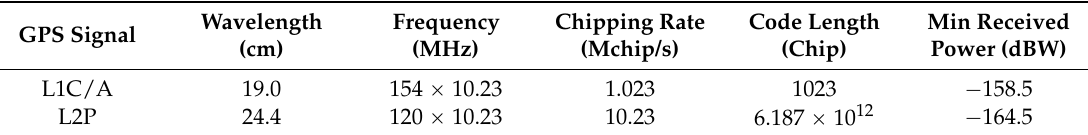
Table 1. Comparison of L1C/A and L2P